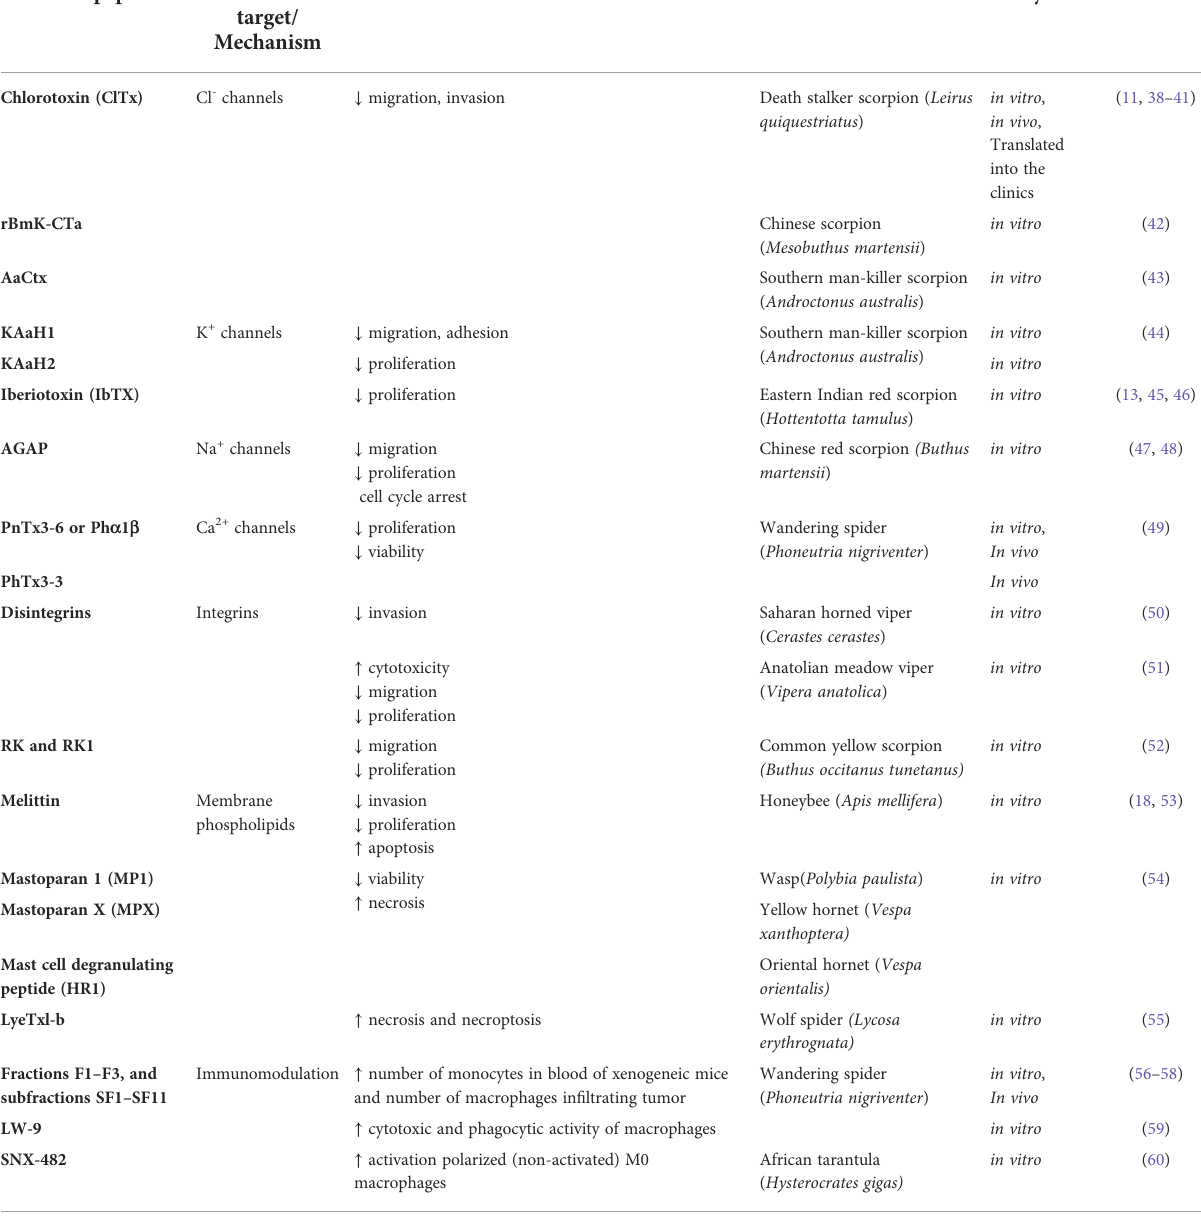
TABLE 1 Bioactive peptides from venoms to resist